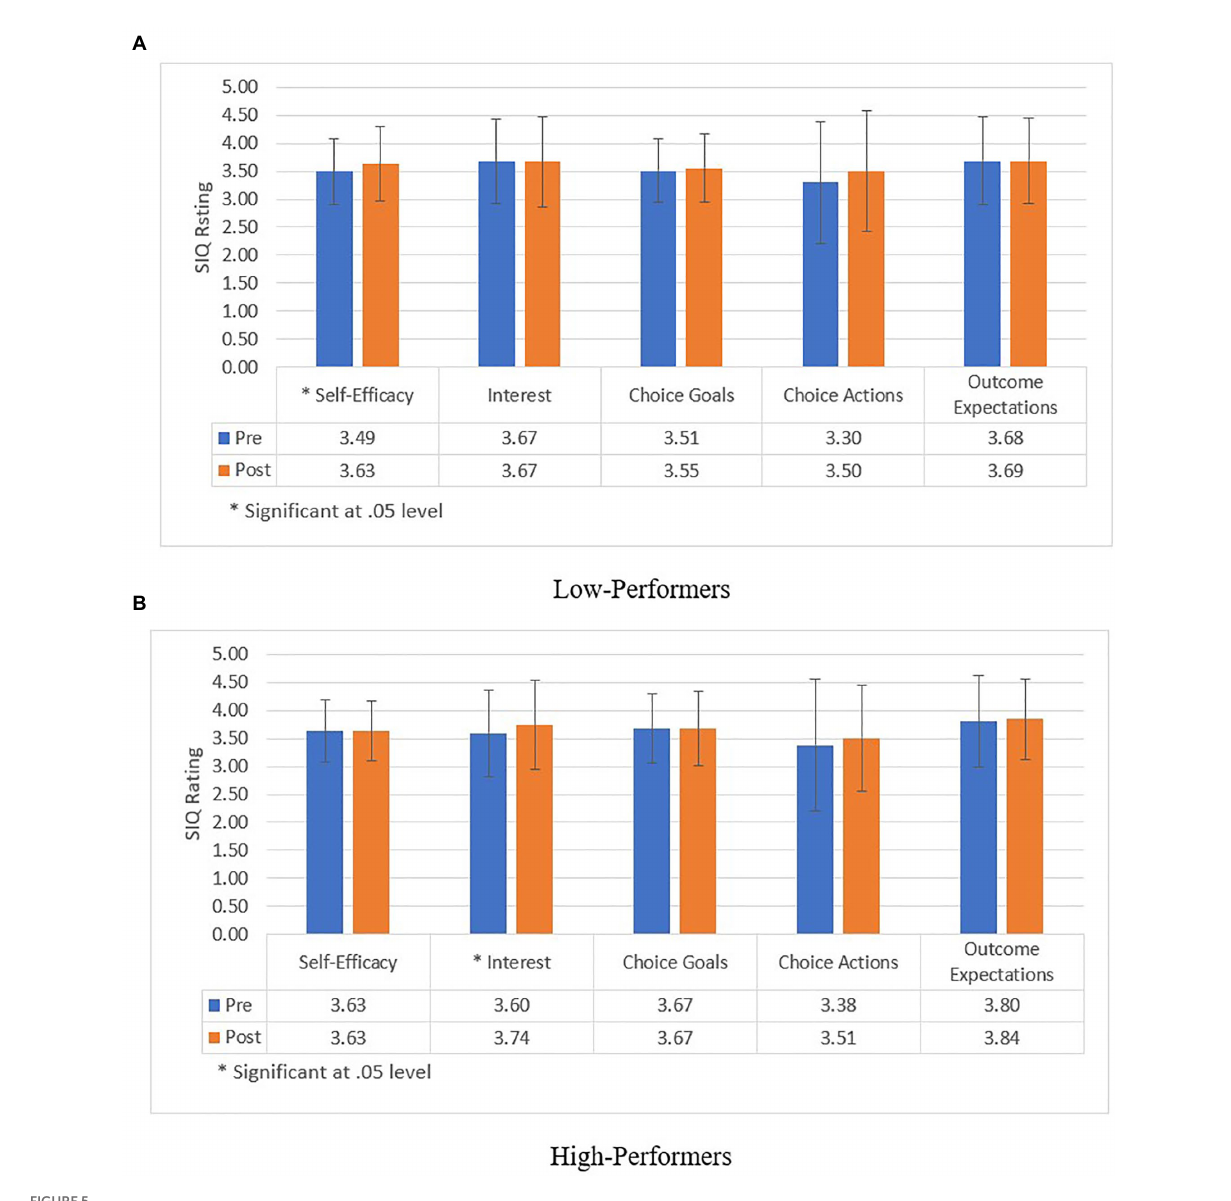
FIGURE 5 Pre- and post-SIQ ratings on each SIC-STEM construct, (A) Low-performers. (B)